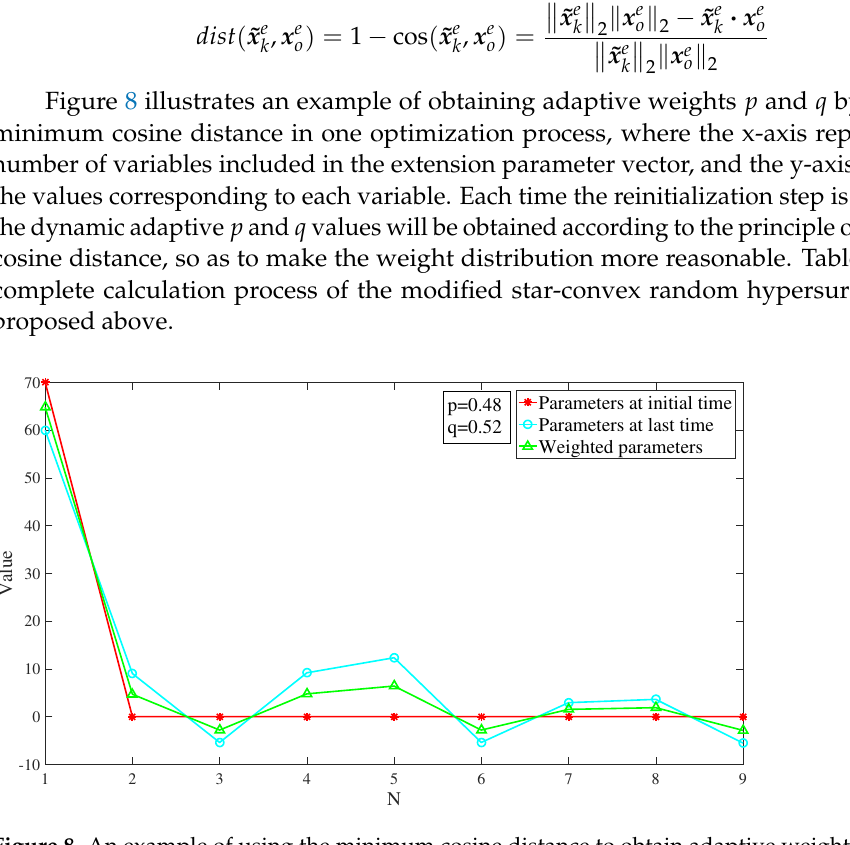
Figure 8. An example of using the minimum cosine distance to obtain adaptive